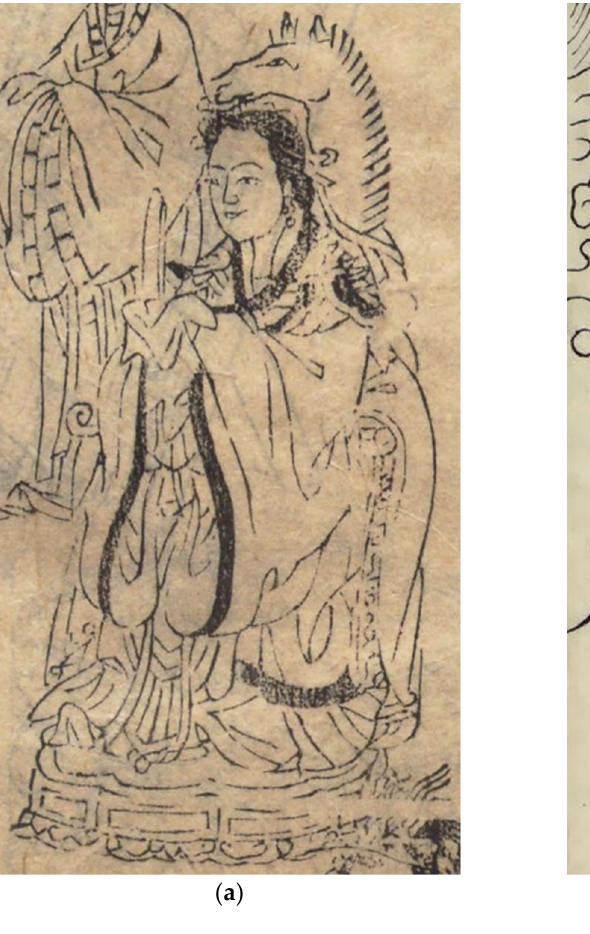
Figure 6. The statue of “Ma-Tou-Niang”: ( a ) “Ma-Tou-Niang”. Photo Source: Nong Shu 农书 (1304); ( b ) “Silkworm girl 蚕女 ”. Photo Source: San Jiao Yuan Liu Sou Shen Da Quan 三教源流搜神大全 (1909).